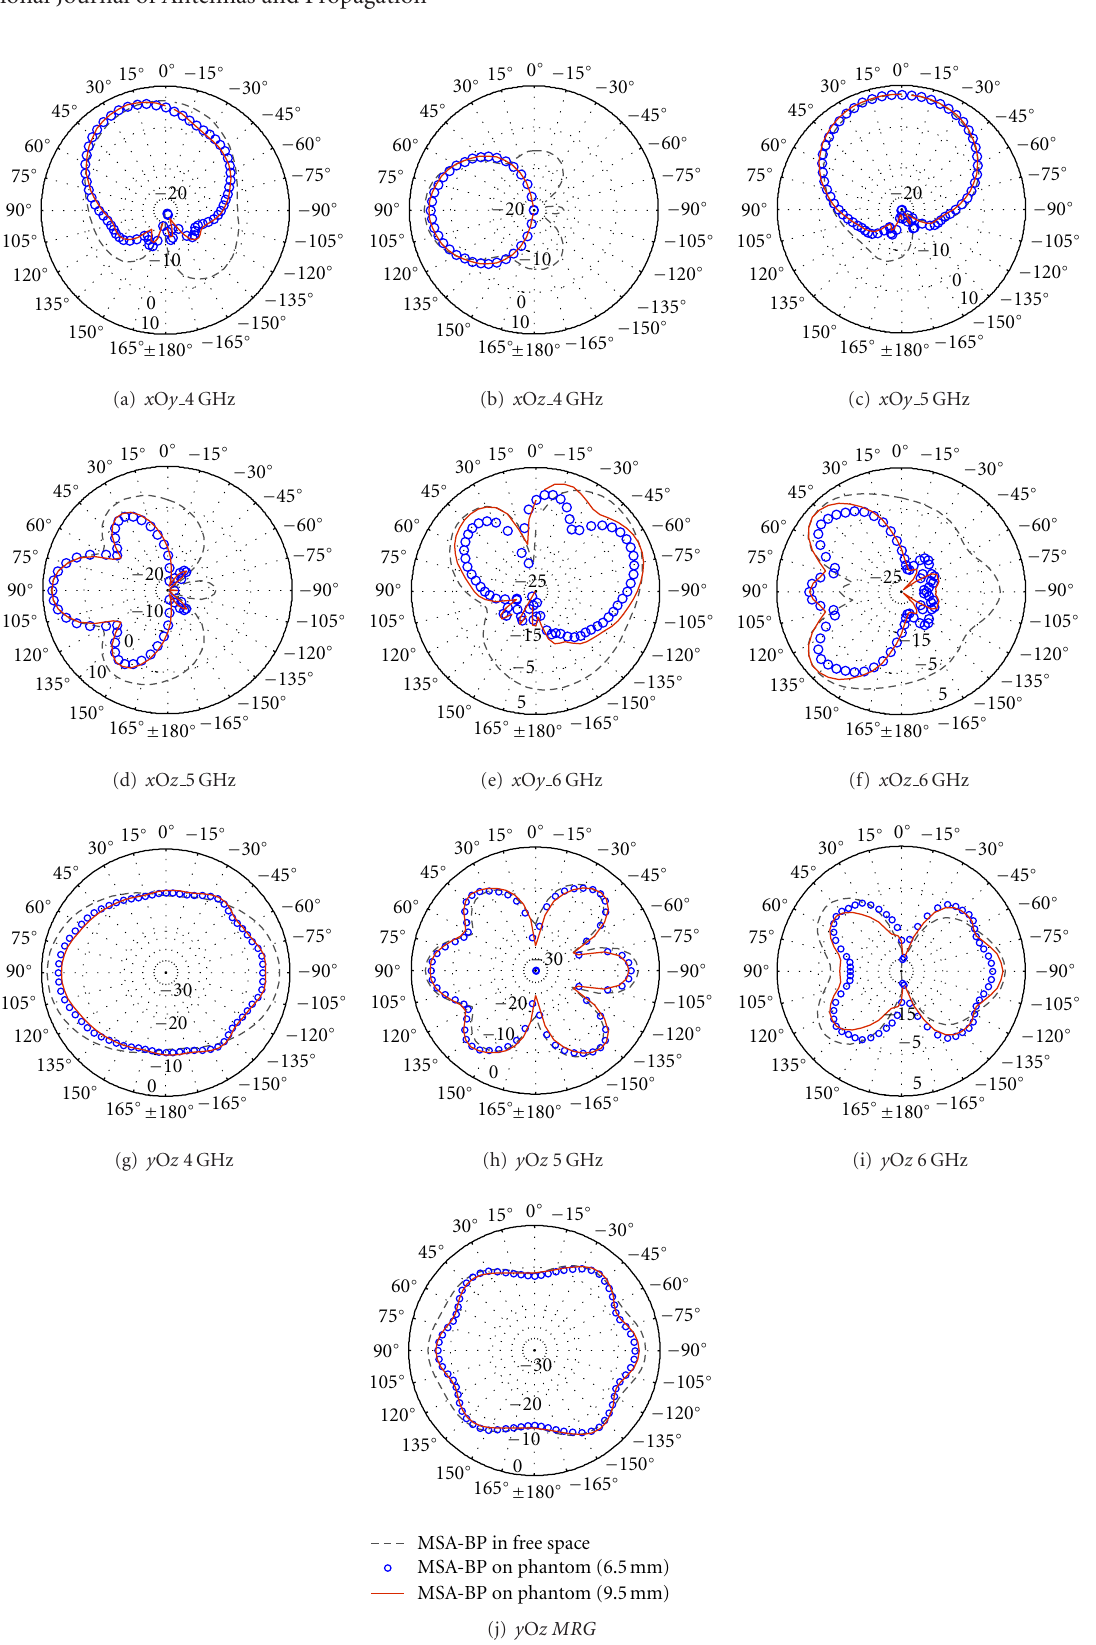
Figure 13: (a)–(i) Realized gain patterns of the MSA-BP in free space or close to an arm phantom in three plane cuts (( θ = 90 ◦ , ϕ = 0, ϕ = 90 ◦ ), (j) mean realized gain of the MSA-BP in the antenna plane y O z ( ϕ = 90 ◦